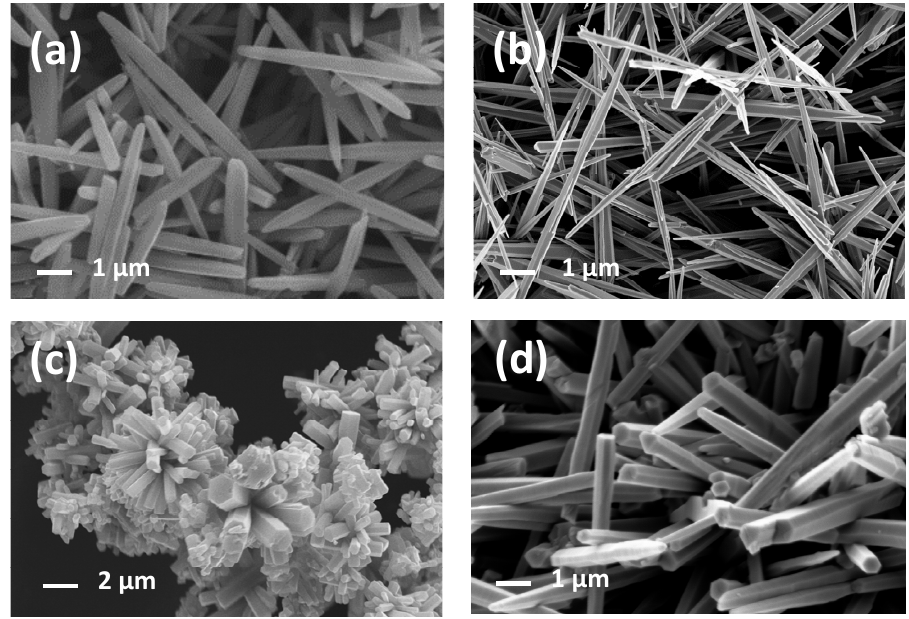
Figure 3. FE-SEM images of stars at different magnification ( a ) and ( b ). In Figure 4, the micrographs of needles, long needles, prisms, and flowers are col- lected. As regards needles, they are characterized by a homogeneous distribution of elongated crystals, 200-300 nm wide and about 3–4 μ m long. Long needles powders are constituted of crystals about 100 nm wide and 7–8 μ m long. Hexagonal prisms about 100 nm wide represent the second last morphology. Finally, the last sample is characterized by micro flowers in which petals are hexagonal prisms, about 300–400 nm wide, and 5–6 μ m long. The growth of the flower structures could be explained taking into account a possible twinning plane (80–89) that corresponds to the plane (10–11). The (80–89) twin- ning plane in zincite was firstly reported in Dana’s Series of Mineralogies [62]. Needles, long needles, prisms, and petals of flowers are all different crystal morphologies of ZnO. The only presence of hexagonal prisms (prisms and flowers samples) is due to the slower growth promoted by a weak base (HMTA). On the contrary, the presence of two pyra- mids both on the top and the bottom of the hexagonal prisms (needles and long needles samples) reveals a faster growth promoted by ammonia solution, which is a base stronger than HMTA.